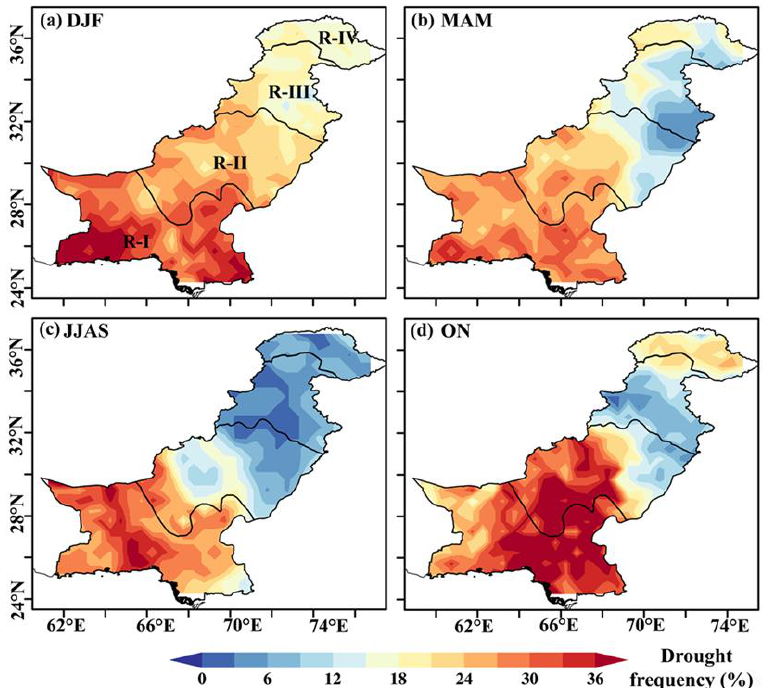
Figure 5. Spatial distribution of seasonal drought frequency (%) for ( a ) DJF (December to February), ( b ) MAM (March to May), ( c ) JJAS (June to September), and ( d ) ON (October to November) seasons. R-I, R-II, R-III, and R-IV represent the hyper-arid, arid, humid, and glacial regions, respectively, for the 1980–2018 periods.